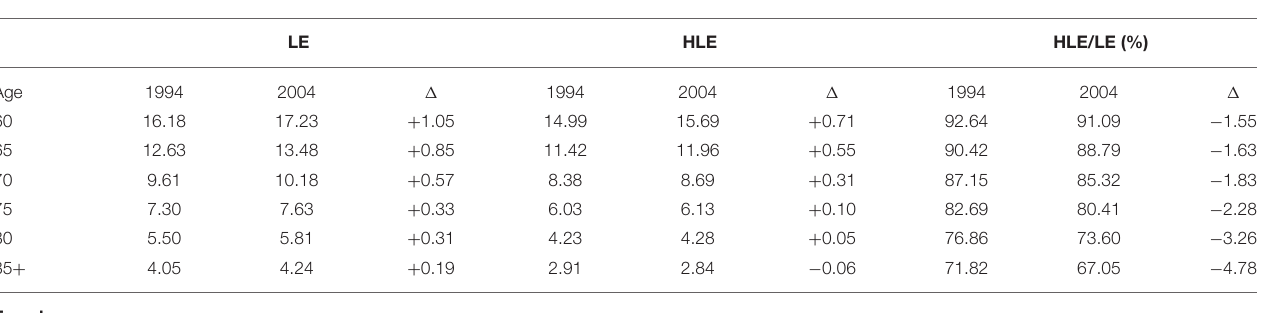
TABLE 1 | Disability-free life expectancy of the elderly, 1994 and 2004.